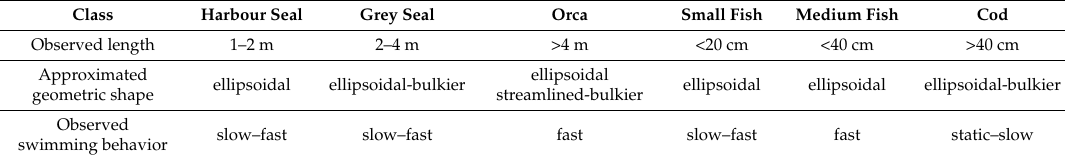
Table 4. Size of observed targets ( R o ) obtained using acoustic images.